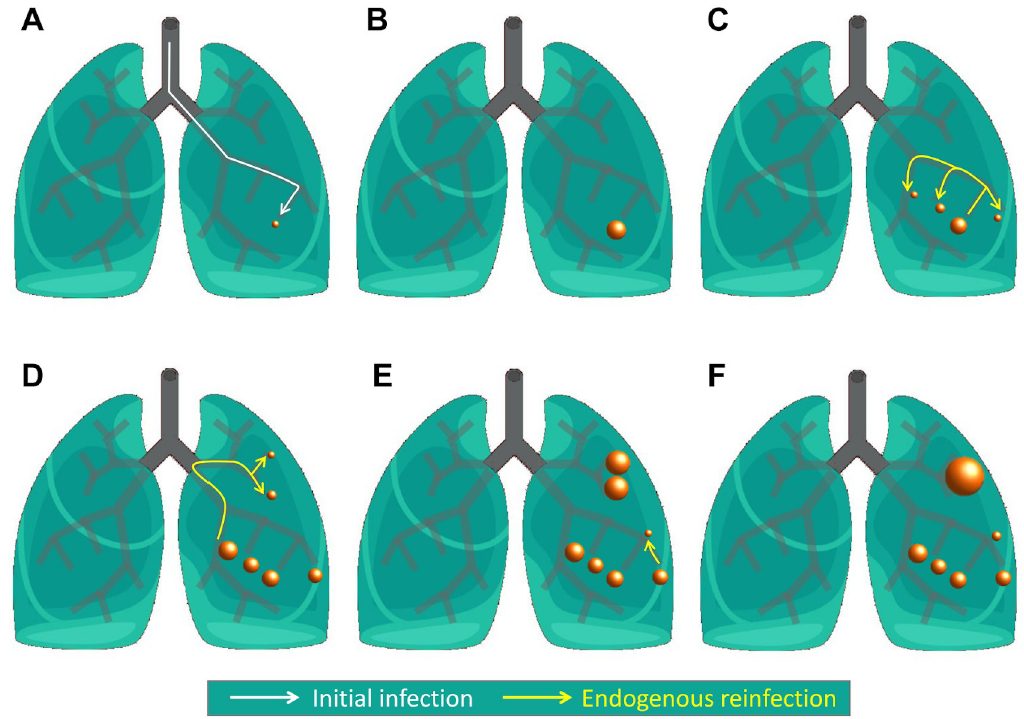
Fig 1. Main features of dynamic hypothesis. Schematic representation of initial infection (A, white arrow) lesions’ growth (A– F), endogenous reinfection (C–E, yellow arrows) and coalescence of neighbouring lesions (F).